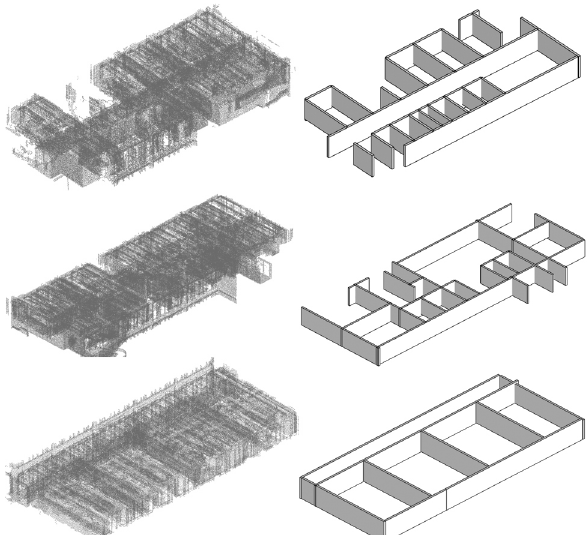
Figure 12 . Some examples of automatic modelling using the algorithm. On the left, the original point clouds, and on the right, the automatically obtained wall